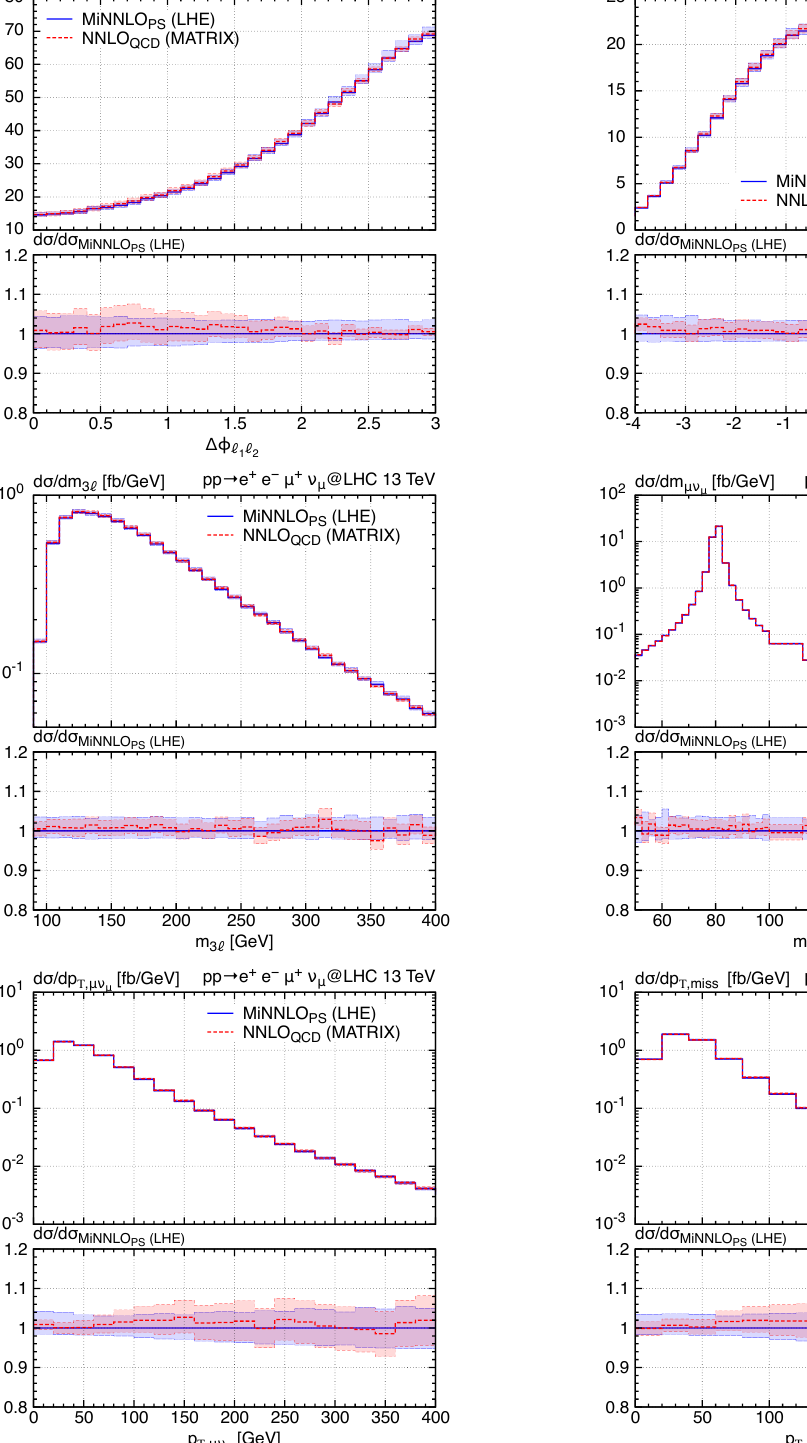
Figure 2. Comparison of MiNNLO PS (blue, solid) and fixed-order NNLO QCD (red, dashed) predictions for W + Z production in the inclusive setup